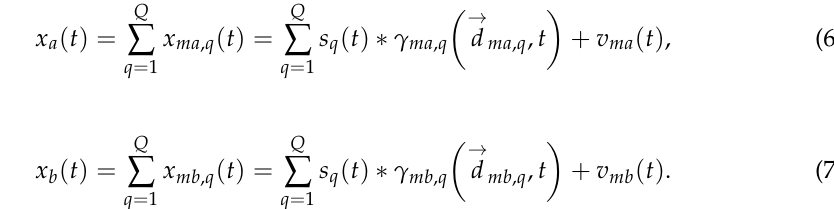
Figure 3. The block diagram of the proposed 3D multiple simultaneous SSL algorithm based on T-shaped circular distributed microphone array, adaptive GCC-PHAT/ML, and GEVD algorithms.